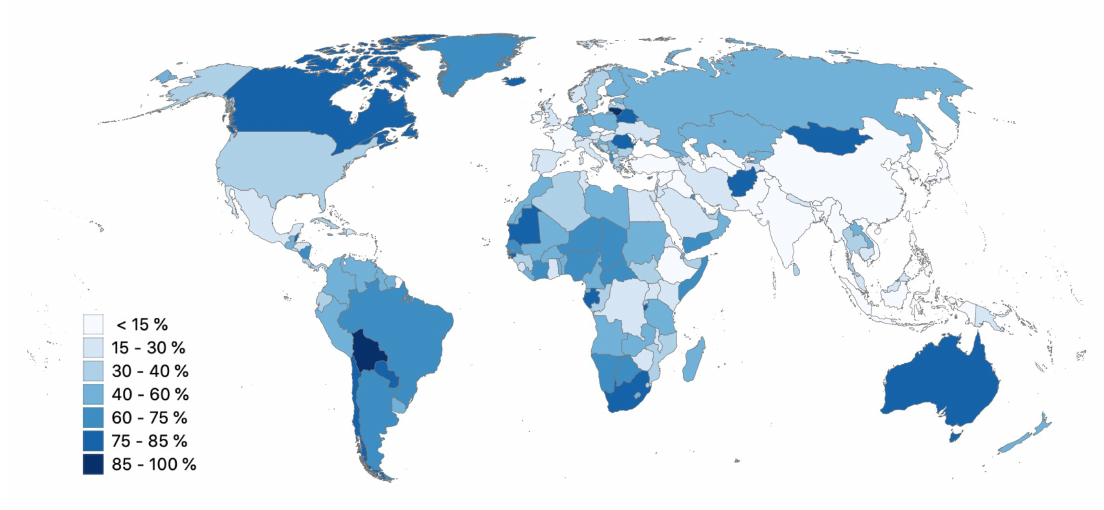
Figure 2. Proportion of the total length of all roads with surface information in OSM ( surface tag) per country (only road classes in Table